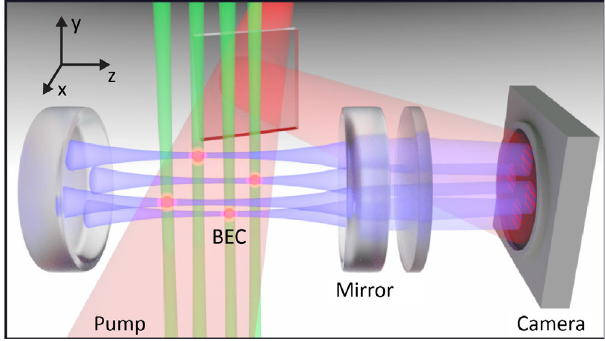
FIG. 1. Sketch of the confocal cavity QED system with atomic spin ensembles confined by optical tweezers. Shown are the cavity mirrors (gray), superpositions of the cavity modes (blue), Bose-Einstein condensates (BECs) (red), optical tweezer beams (green), transverse pump beam (red), and interference on a charge-coupled device (CCD) camera for holographic imaging of spin analogy to apparatuses employing high-numerical-aperture lenses near optically trapped atoms [43].